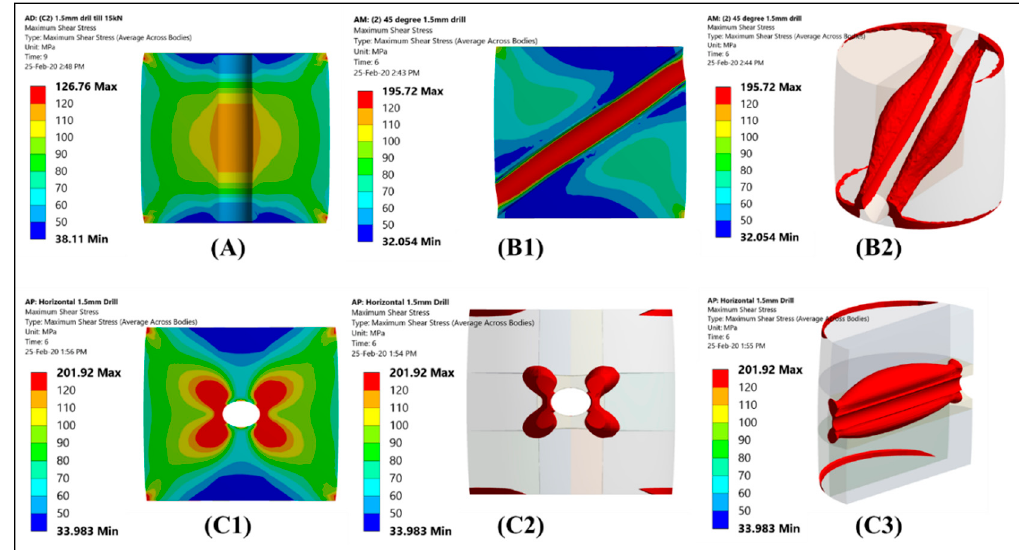
Figure 5. Maximum shear stress plots at 9000 N for ( A ) vertical drill hole orientation, ( B1 , B2 ) angular drill hole orientation and ( C1 , C2 , C3 ) horizontal drill hole orientation.